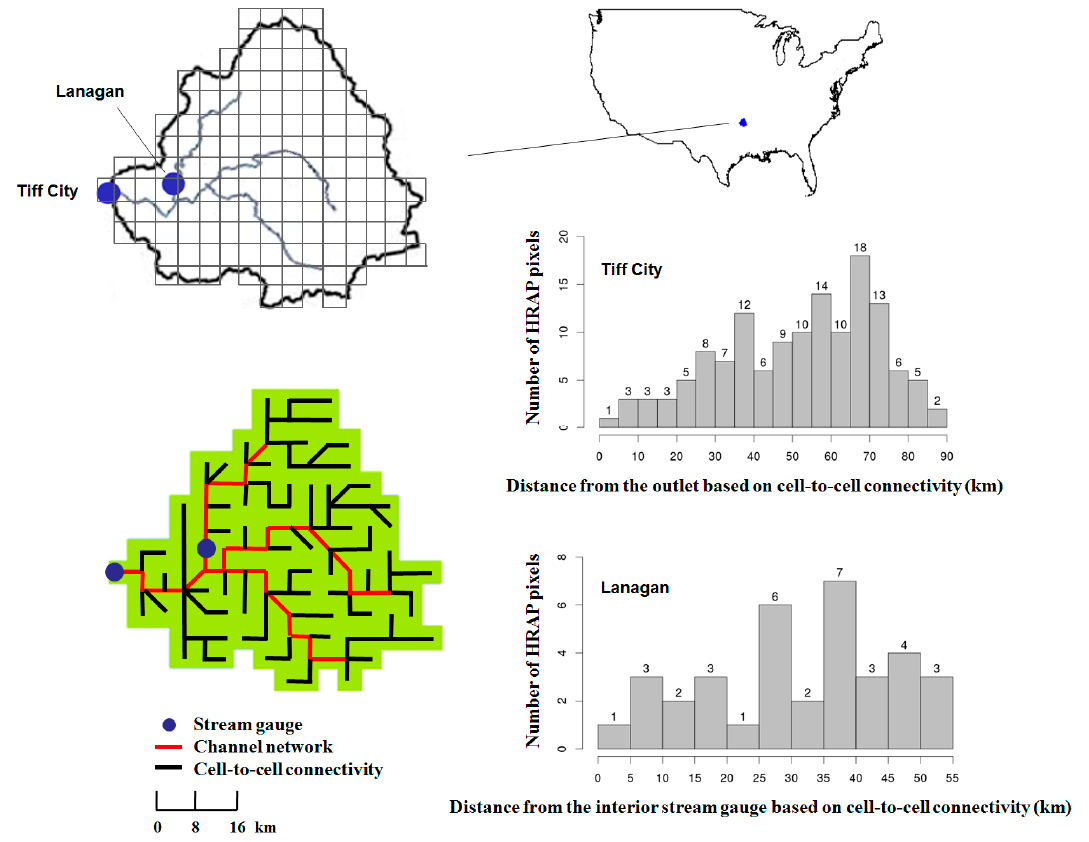
Figure 2. The TIFM7 study basin (2258 km 2 ); Lanagan (619 km 2 ) stream gauge is about 28 km from the basin outlet calculated based on the cell-to-cell connectivity. The sub-basin Lanagan consists of 35 HRAP cells (~26% drainage area of the basin).